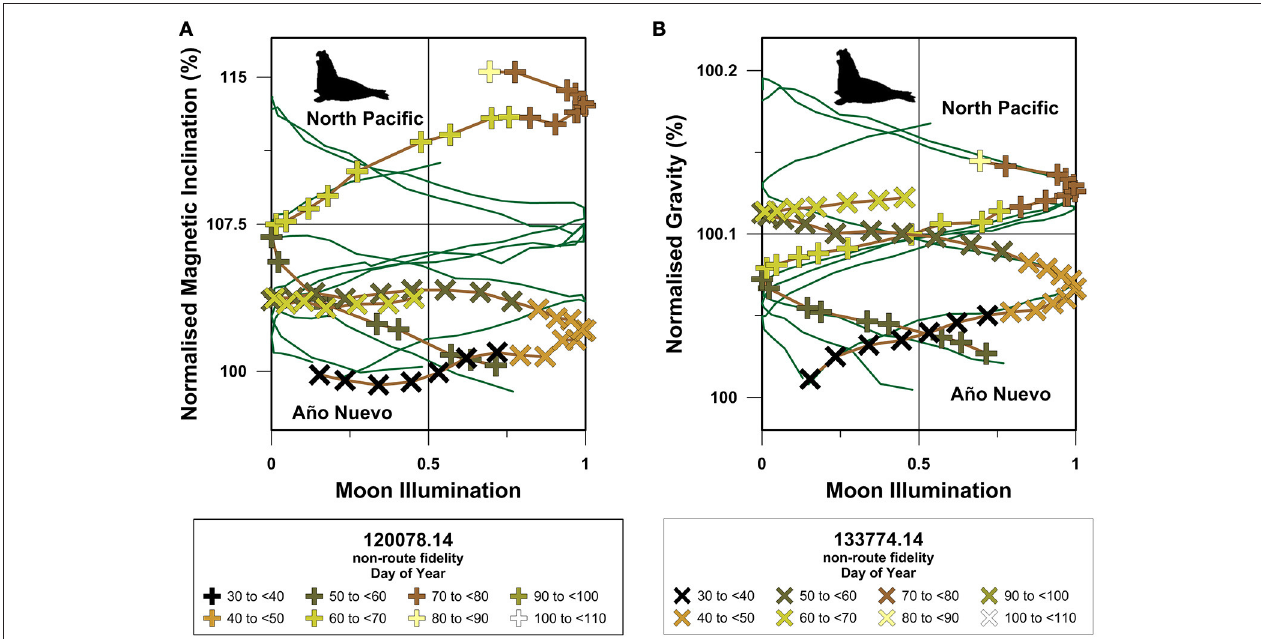
FIGURE 10 | Site-normalized North Pacific northern elephant seal magnetic inclination and gravitational trajectories. In this figure geocentric magnetic inclination and latitude and bedrock dependent g L + g B values have been normalized to the values present at the locations inhabited immediately prior to the onset of long-distance open-ocean migration at the individual level. Site-normalized magnetic inclination (A) and gravitational acceleration (B) values are displayed as percentages and are plotted against the moon illumination cycle as in Figures 5 – 7 . Route fidelity movements are shown as dark green lines and non-route fidelity movements are symbolized as indicated in the figure legends. Non-route fidelity track symbol colors correspond with day of the year and exceed 365 days when the tracked movement spanned Julian calendar years.